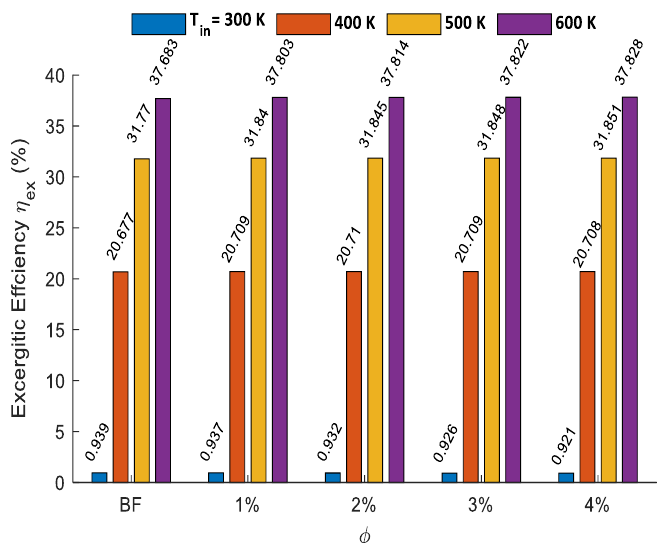
Figure 11. Exergy efficiency for base fluid and hybrid nanofluid under different temperatures and concentrations.